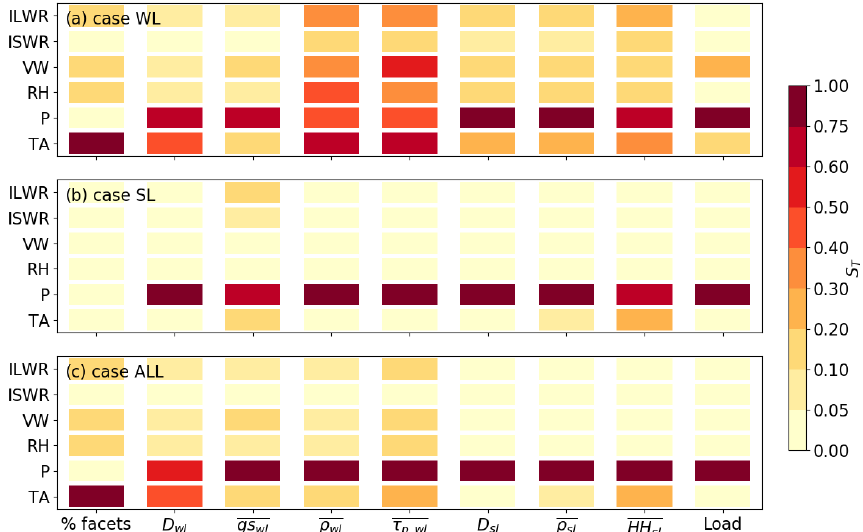
Figure 5. Total sensitivity index of different weak layer and slab variables on meteorological input uncertainty on 9 March 2017 for (a) case WL, (b) case SL and (c) case ALL. Variables are the proportion of facets (% facets), weak layer thickness ( D wl ), weak layer grain size (gs wl ), weak layer density ( ρ wl ), weak layer shear strength ( τ p , wl ), slab thickness ( D sl ), slab density ( ρ sl ), hand hardness index of the slab (HH sl ) and load due to the slab weight